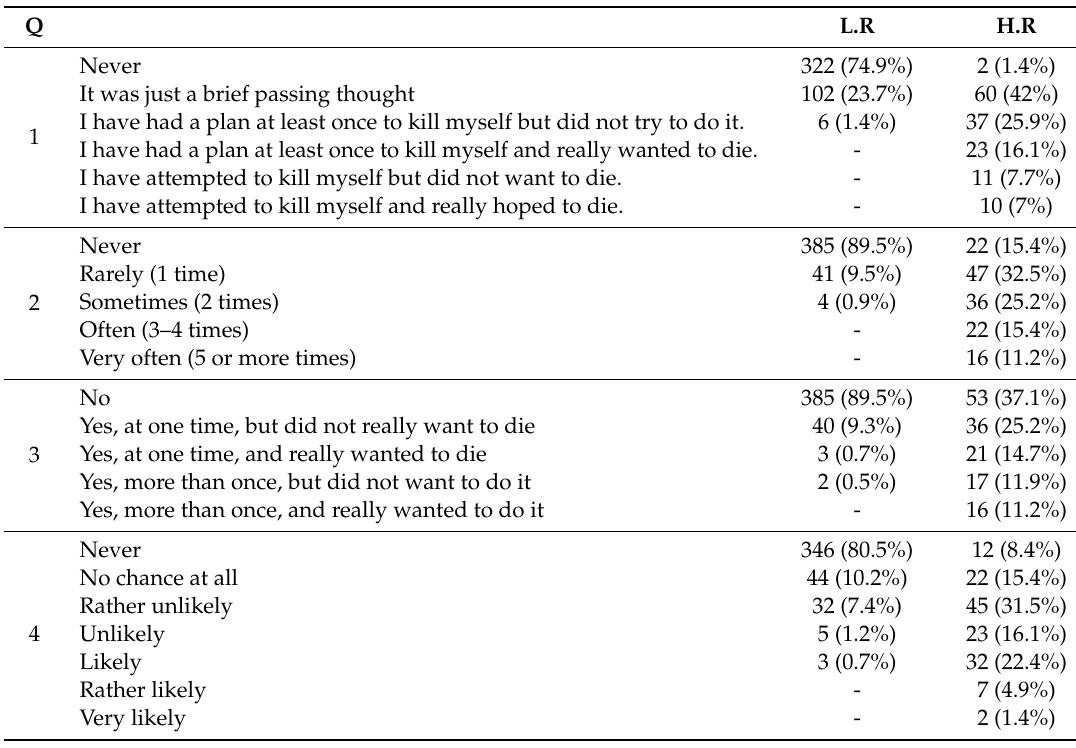
Table A7. Frequency of the Suicide Behaviors Questionnaire-Revised (SBQ-R) in low-risk (L.R) and high-risk (H.R) groups (Cut-o ff = 8, for the first question is 2). Q L.R